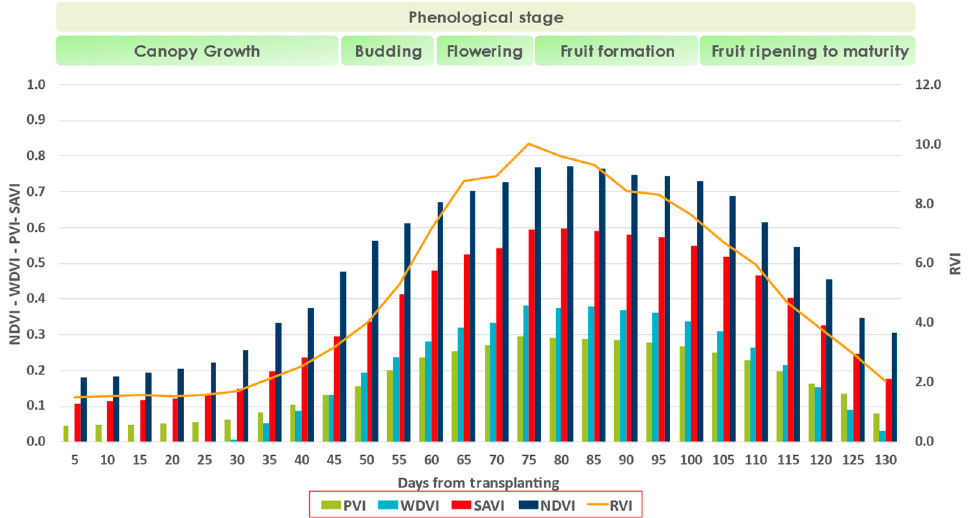
Figure 6. The mean values of the five VIs: PVI (green); WDVI (light blue); SAVI (red); NDVI (blue); RVI (orange), which has different range of values and is incorporated in the secondary axes. Table 4. The Pearson coefficient representing the relationships between the derived VIs and the yield of the Dexter hybrid.